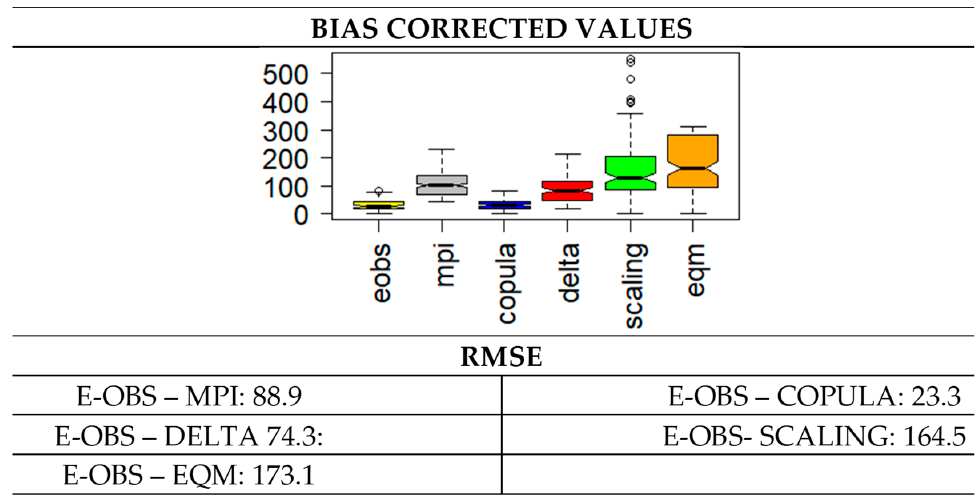
Figure 6. Comparison of the copula method with three other bias correction methods (delta, scaling, empirical quantile